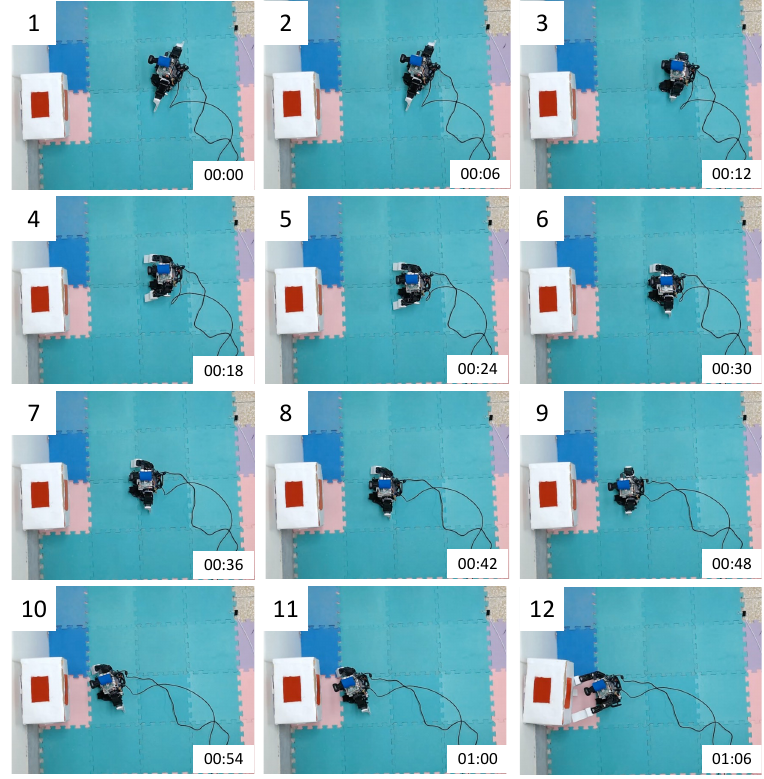
Figure 6. Experimental results of one HR without fuzzy technique.